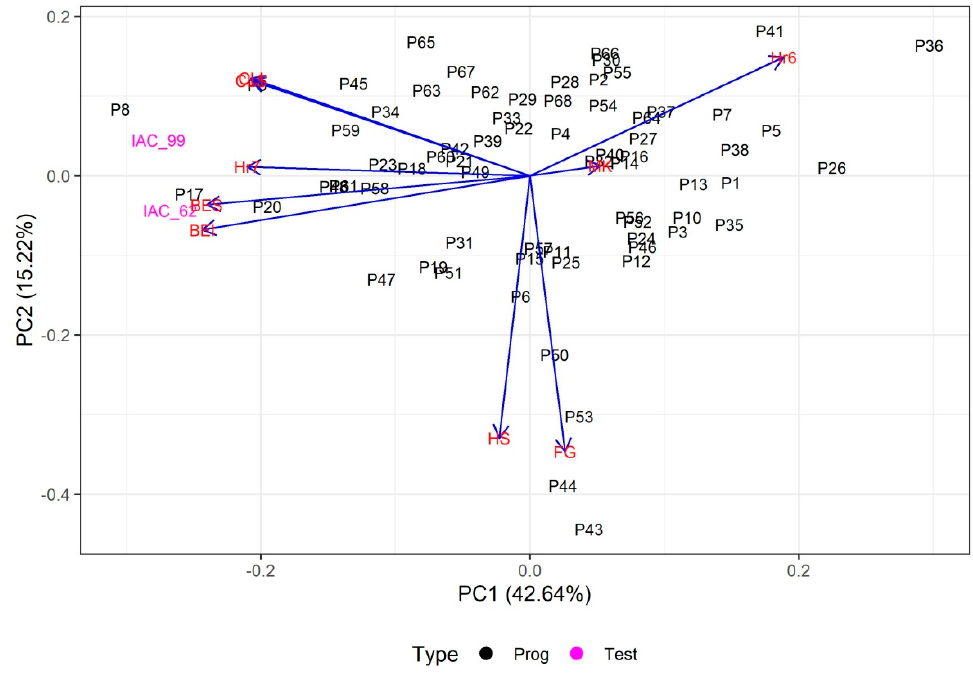
Figure 3. Dispersion of the progeny means as a function of the coordinates for the first and second canonical dimensions obtained from nine traits: CLI, CLS, BEI, BES, MK, HS, FG, Hr7, and Hr6.